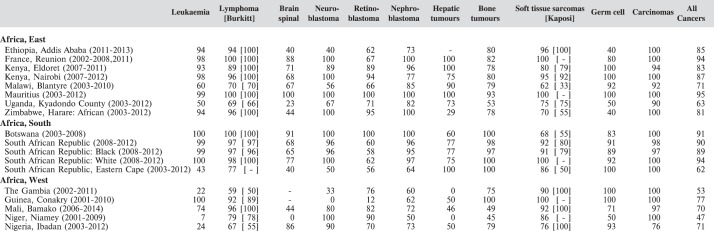
Percentage of microscopically verified cases – both sexes.